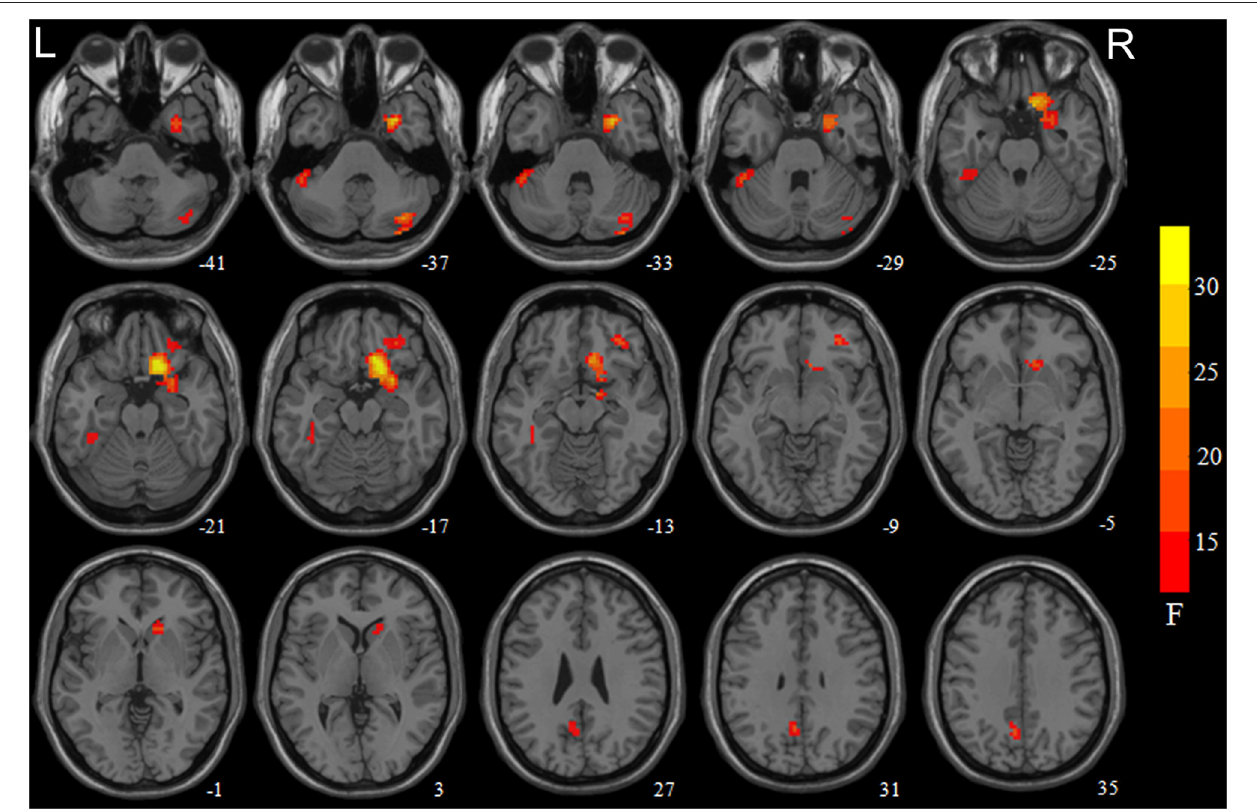
FIGURE 1 | Brain areas with significant main effect of smoking on regional homogeneity (ReHo) revealed by the 2-way analysis of covariance with age and education levels as covariates. Regions in red-yellow are brain areas where ReHo was significantly altered in smokers relative non-smokers. The areas include the right medial orbitofrontal cortex (OFC) extend to the ventral striatum/amygdala/parahippocampa gyrus, right cerebellum crus1/2, left precuneus, left cerebellum crus1 extended to the inferior temporal gyrus/fusiform gyrus, and right lateral OFC. The results were multiple compared at voxel-level p < 0.05 (FDR corrected). The left side of the image corresponds to the left hemisphere of the brain.